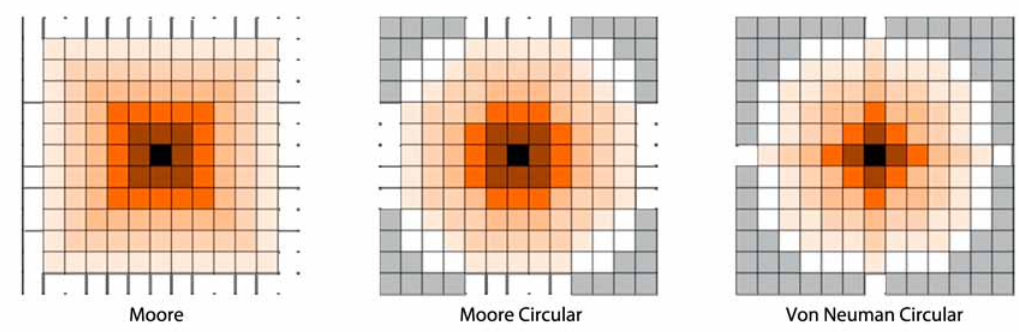
Fig. 3. Neighborhood types and